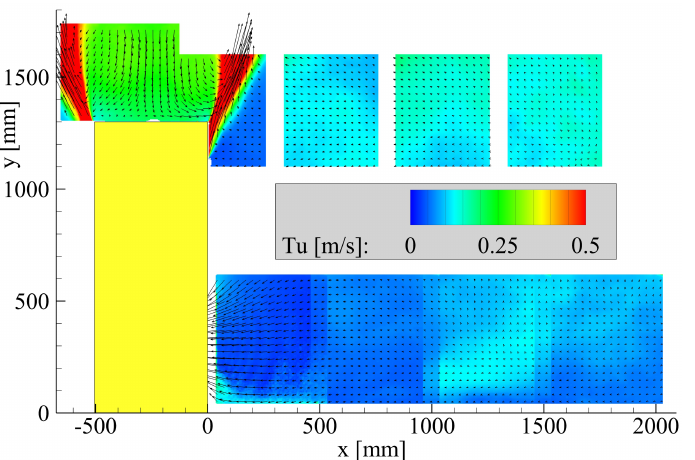
Figure 4. Mean turbulent velocity fluctuations at an air cleaner flow rate of 1500 m 3 /h. The vectors visualize the direction and strength of the turbulent air flow. The color quantitatively illustrates the magnitude of the